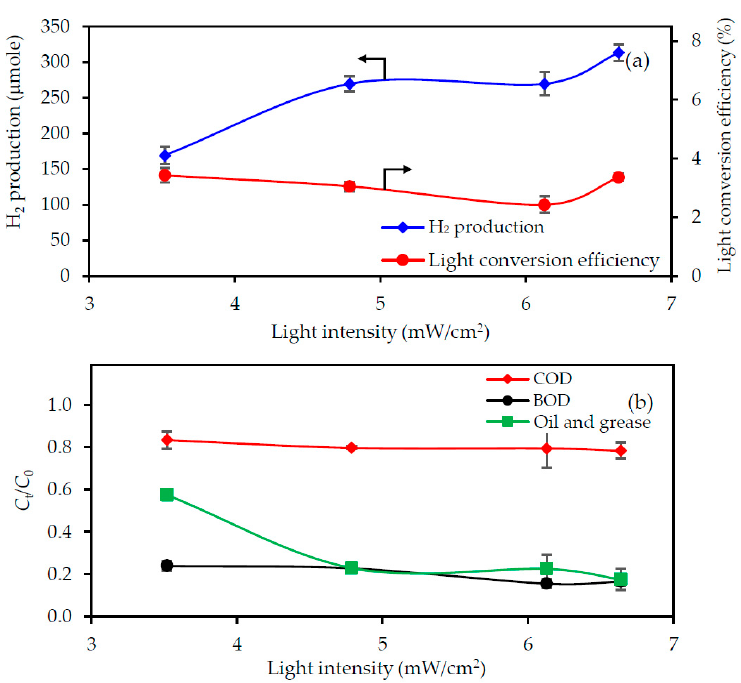
Figure 5. Effect of the UV light intensity on the level of ( a ) H 2 production with light conversion efficiency and ( b ) pollutant removal from the 3.3-fold diluted acid-pretreated biodiesel wastewater at an initial pH of 2.3 with a photocatalyst loading of 4.0 g/L for 4 h.